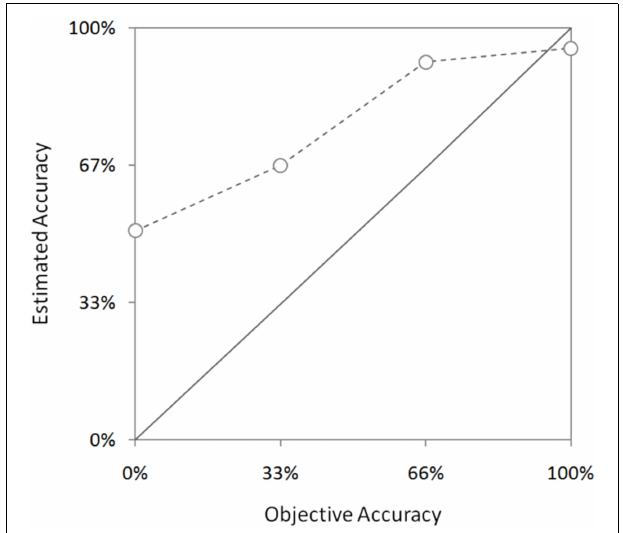
FIGURE 2 | Estimated accuracy by objective accuracy. Error bars indicate one standard error of the mean.